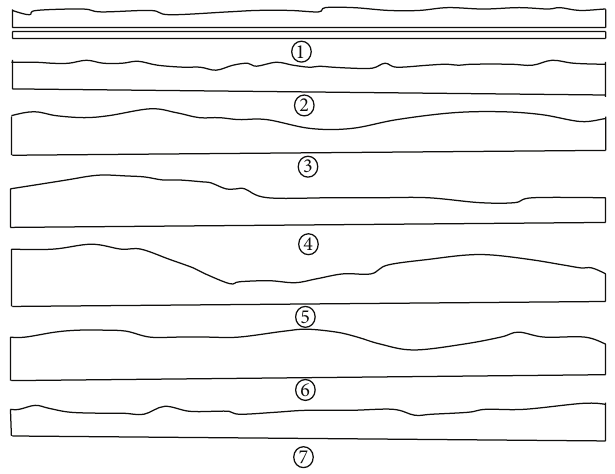
Figure 6: Typical profile curves of joint surface (sample size is 22 cm and scale is 1: 3). A Planar and smooth (carbonaceous slate foliation). B Planar and rough (coarse-grained granite joint). C Undulating (siltstone ripple bedding). D Stepped-undulating (siltstone ripple bedding). E Stepped-undulating (siltstone ripple bedding). F Stepped-undulating (siltstone ripple bedding). G Planar-undulating (plagioclase hornblendite joint).